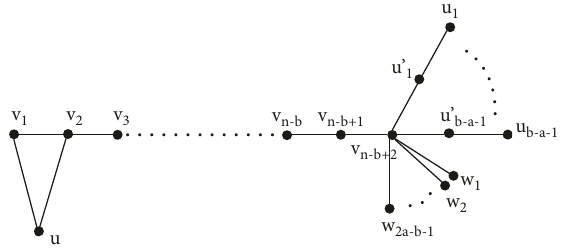
Figure 6: A graph with sm ( G ) � a,sm